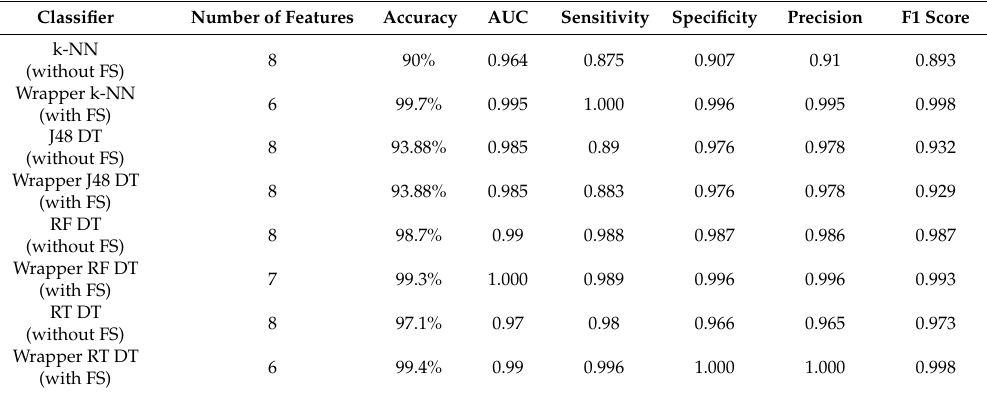
Table 10. The classification results before and after feature selection results using the random search method for the combination of the two datasets.